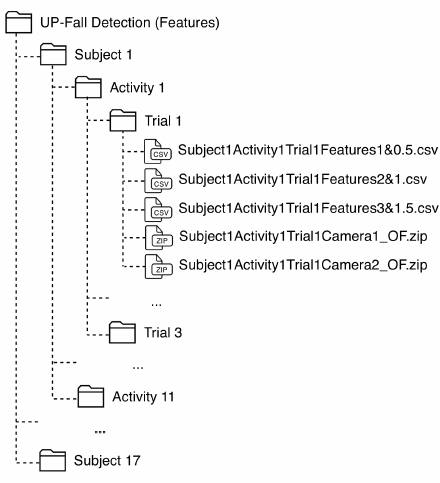
Figure 5. Organization of the feature dataset.